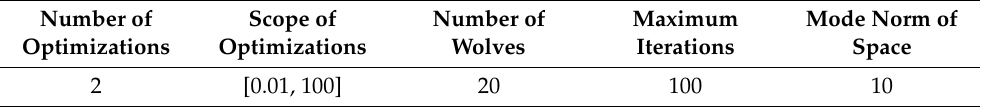
Table 5. Parameter values of the IGWO